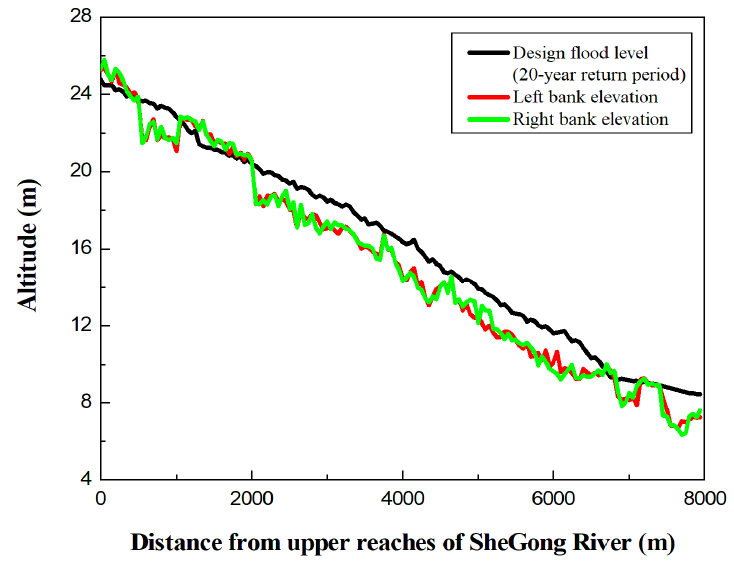
Figure 7. Comparison of current bank elevation and design flood level (20-year return period). Table 3. Cost of land acquisition and house demolition for Scheme 2 and Scheme 3.